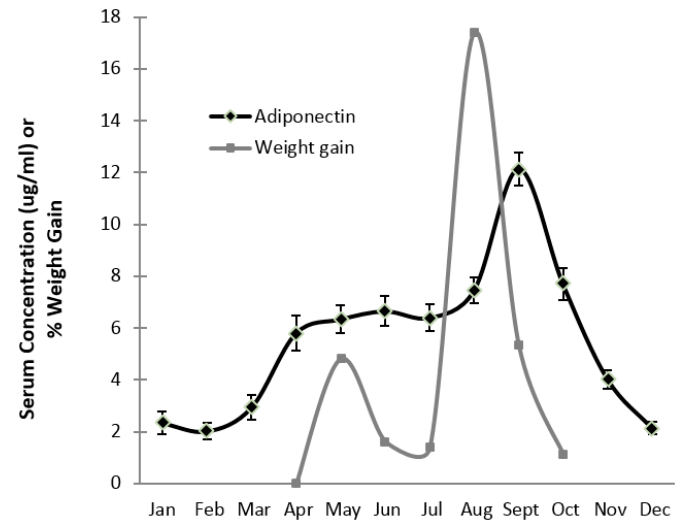
Figure 3. Monthly measurement of serum adiponectin compared to percent weight gain in 16 brown bears. Adiponectin data presented as means ± SD. The concentration of adiponectin mirrored weight gain through the active season (April–October) and peaked as rapid weight gain occurred in August and September. Serum adiponectin was significantly lower during hibernation (November–February) relative to the summer active period.